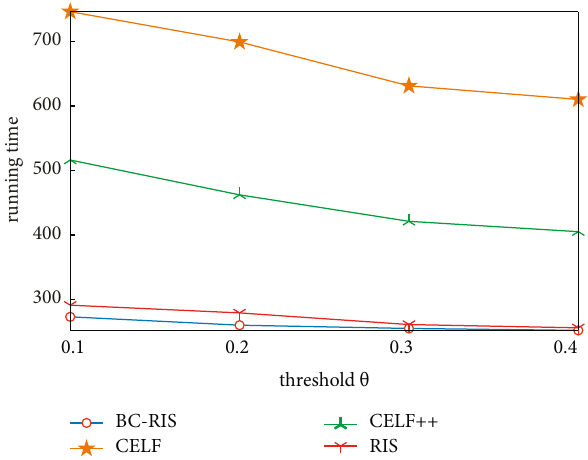
Figure 6: The running time of different influence maximization algorithms, when number of seed nodes is 20.